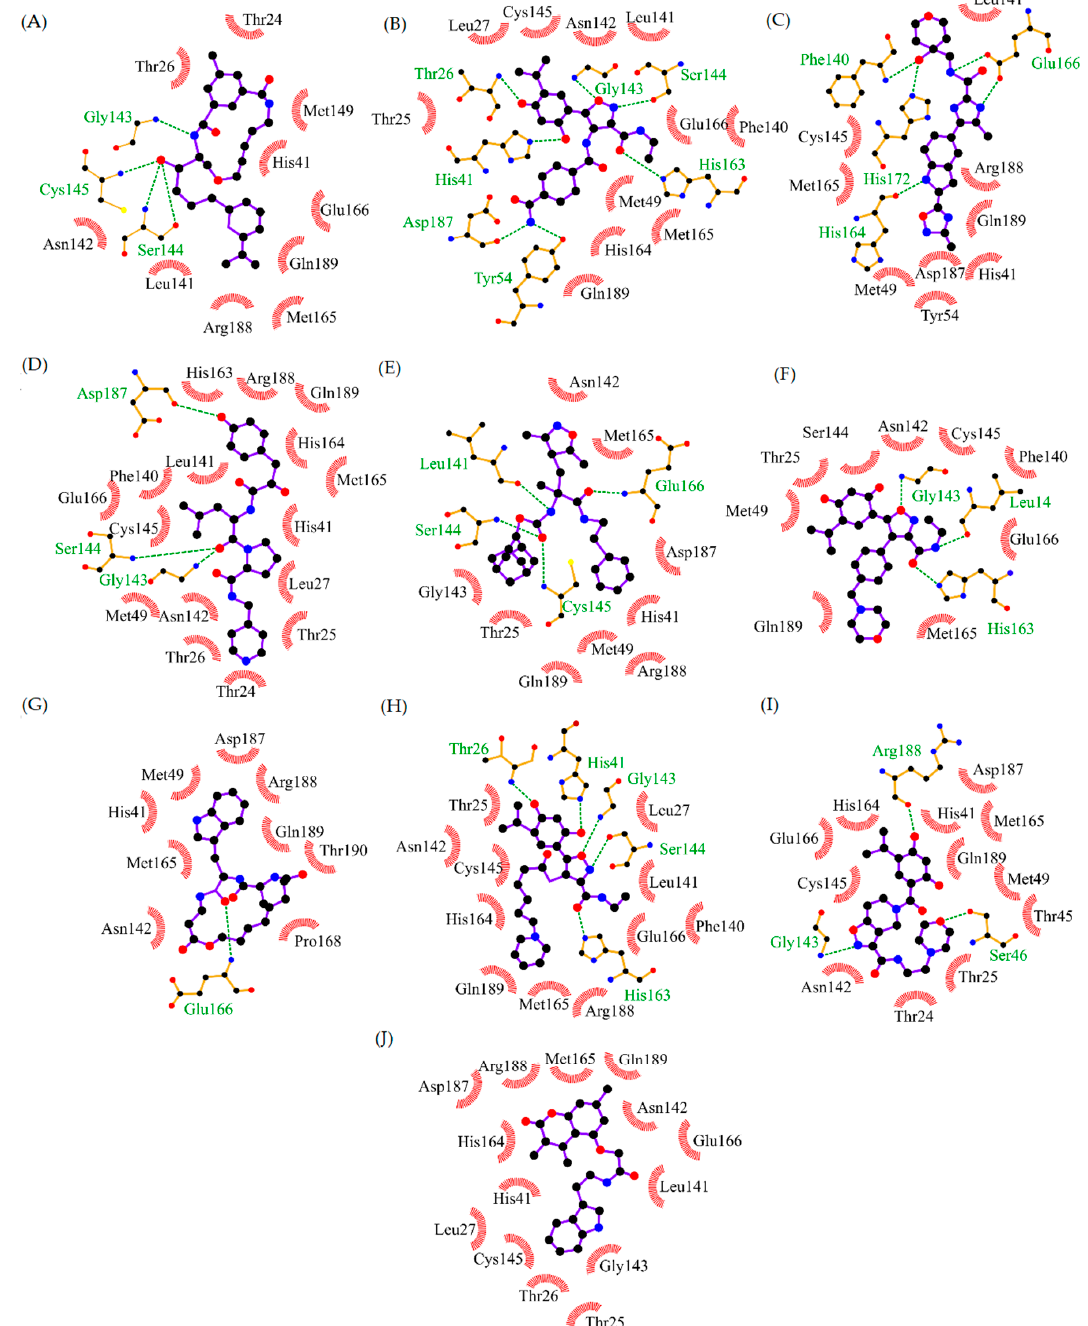
Figure 4. Top 10 potential inhibitors of SARS-CoV-2 Mpro from the ChEMBL database obtained by fingerprints and molecular docking. ( A ) CHEMBL2047043 (D.S.: − 9.6 kcal / mol). ( B ) CHEMBL1940937 (D.S.: − 9.1 kcal / mol). ( C ) CHEMBL3666013 (D.S.: − 8.8 kcal / mol). ( D ) CHEMBL562054 (D.S.: − 8.3 kcal /